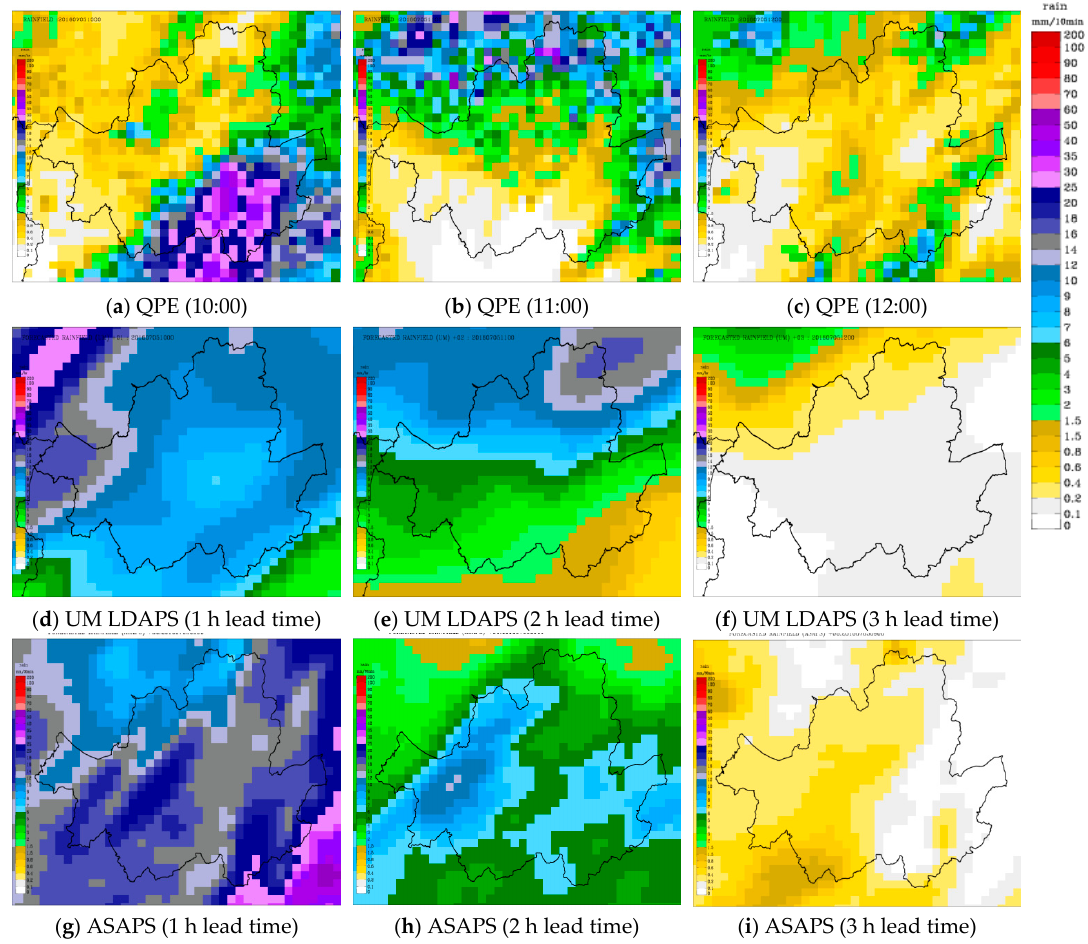
Figure 5. Comparison between actual quantitative precipitation estimates (QPE, a – c ) and QPF forecasts by the numerical weather prediction (NWP) models Unified Model Local Data Assimilation and Prediction (UM LDAPS) ( d – f ) and Advanced Storm-scale Analysis and Prediction System (ASAPS) ( g–i ) in the Seoul area with lead times of 1–3 h starting from 09:00, July 5, 2016.